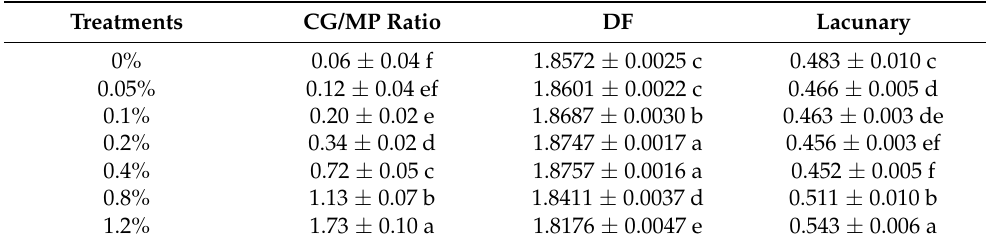
Table 3. The ratio of CG/MP phase area, DF, and lacunary of composite MP gels with various CG. Treatments CG/MP Ratio DF